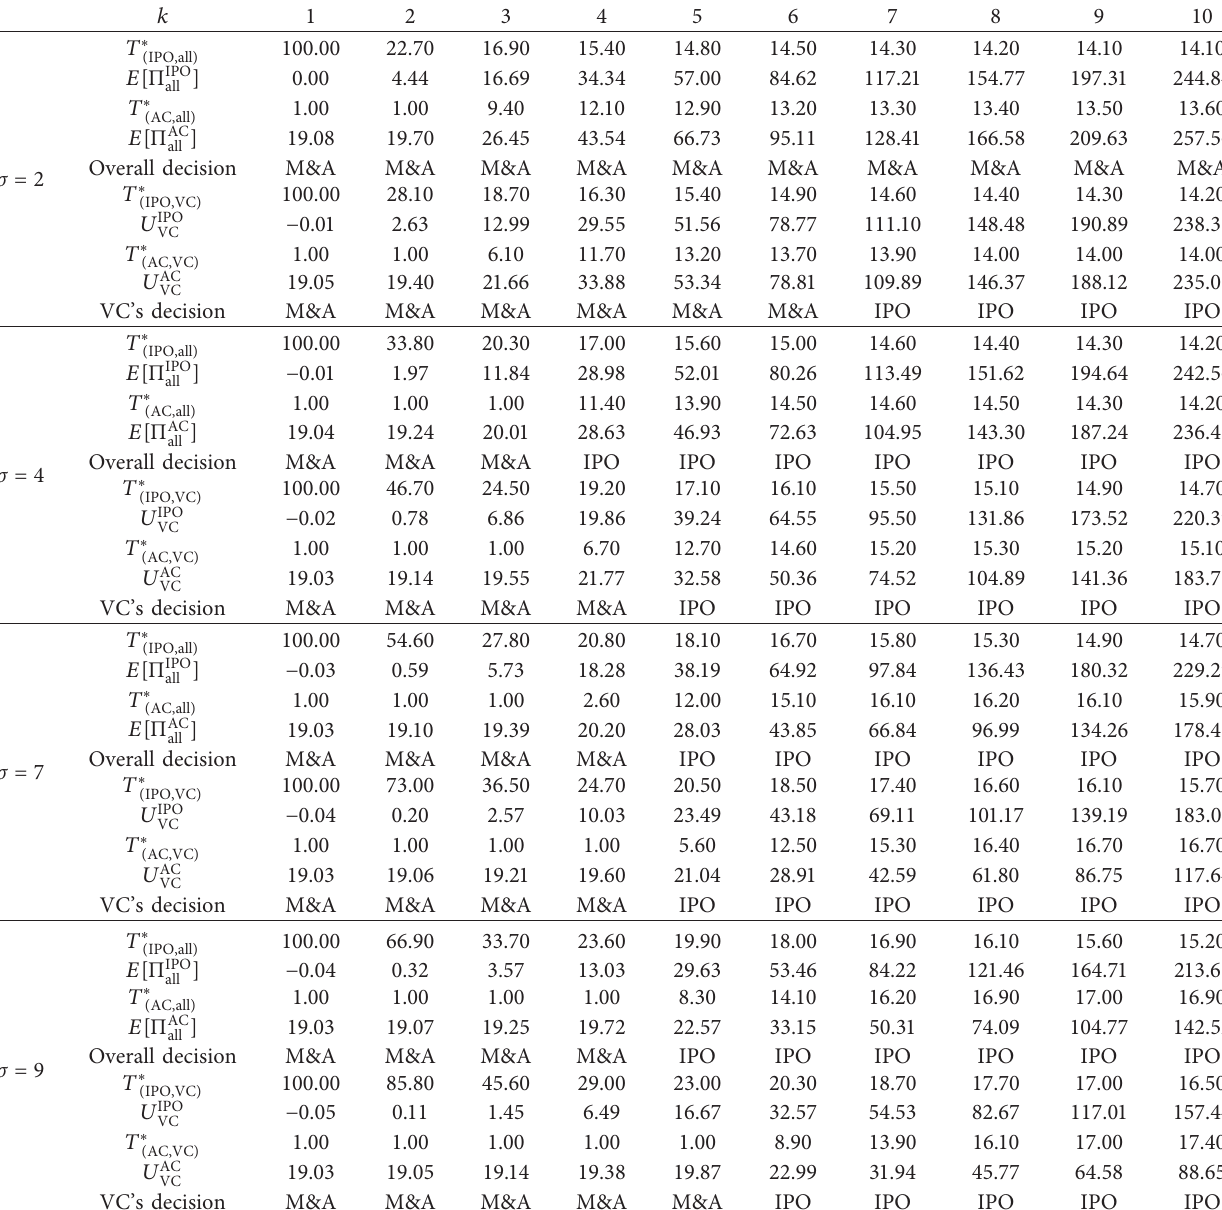
Table 1: Numerical simulation for exit